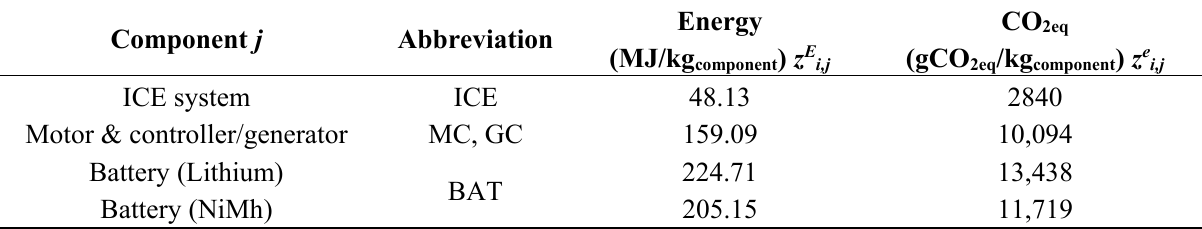
Table 4. CTG factors (MJ and gCO 2eq per kg of the respective component in the vehicle)